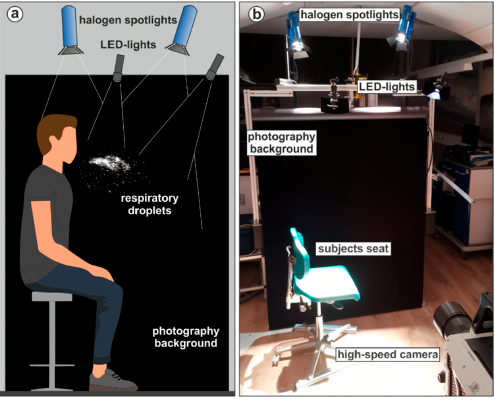
Figure 1. ( a ) Concept figure of the droplet test stand from the high-speed camera perspective. In total, two halogen spotlights and two LED lights illuminated the area in front of the subjects; ( b ) photography of the implemented test stand without subject.